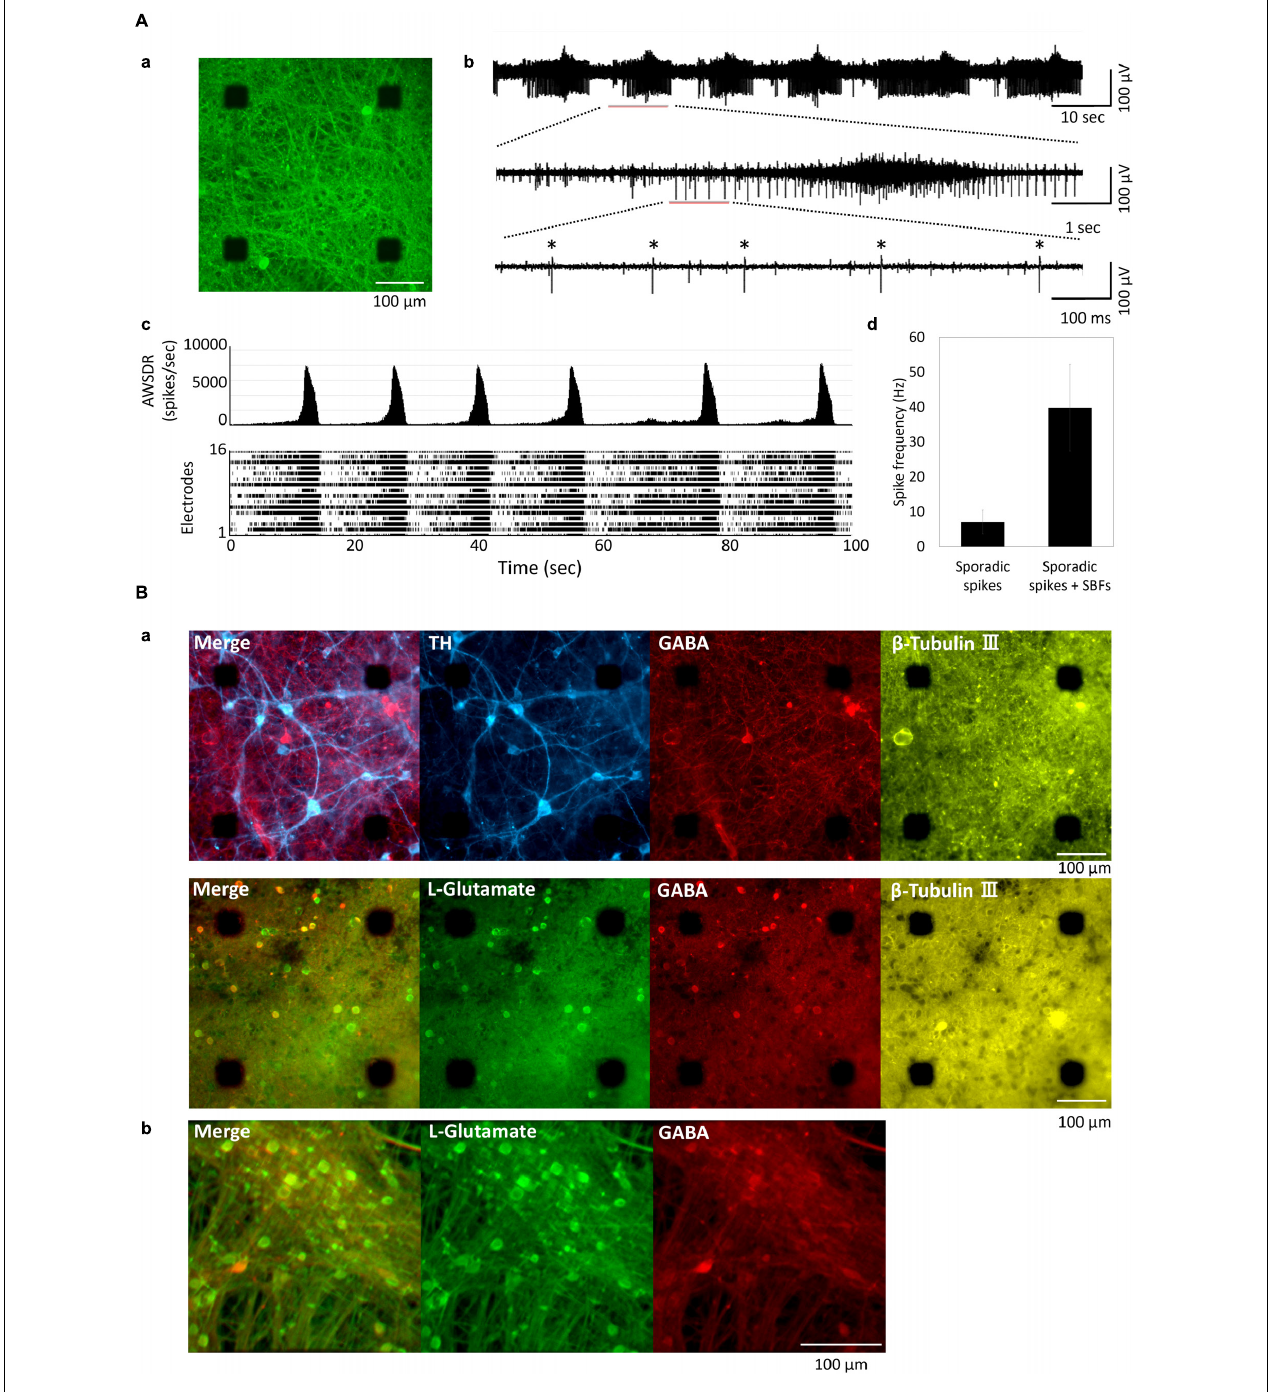
FIGURE 1 | Cultured of human iPSC-derived neurons. (A) Human iPSC-derived neurons on micro-electrode array (MEA) chip and spontaneous activities. (a) Immunofluorescent image of human iPSC-derived neurons (iCell DopaNeurons) at 51 weeks in vitro (WIV). Images show the neurons using β -tubulin III immunostaining. Scale bars = 100 µ m. (b) Typical waveform of spontaneous firings on different time scales for one electrode at 11 WIV. Asterisk ( ∗ ) indicates the firings of single neuron. (c) Array-wide spike detection rate (bin = 100 ms) and raster plots of spontaneous firing for 100 s at 16 electrodes per well. (d) Spike frequency of dopaminergic (DA) neuron. Spike frequency of spontaneous firings for 15 min was calculated for each electrode in cultured iCell DopaNeurons at 11 WIV ( n = 16 electrodes/well, 4 wells). The analysis was divided into SBFs and non-SBF firings (sporadic spikes). In sporadic spikes, an electrode in which a spike was observed at 1 Hz or more was calculated as an active channel. (B) Immunofluorescence image of cultured human iPSC-derived neurons. (a) Immunofluorescence image of DA neurons on an MEA chip after 48 WIV. Tyrosine hydroxylase (TH, cyan), gamma-Aminobutyric acid (GABA, red), L-Glutamate (green), β -Tubulin (yellow). Scale bar = 100 µ m. (b) Immunofluorescence image of glutamatergic neurons (iCell GlutaNeurons) on an MEA chip at 18 (WIV). Scale bar = 100 µ m.